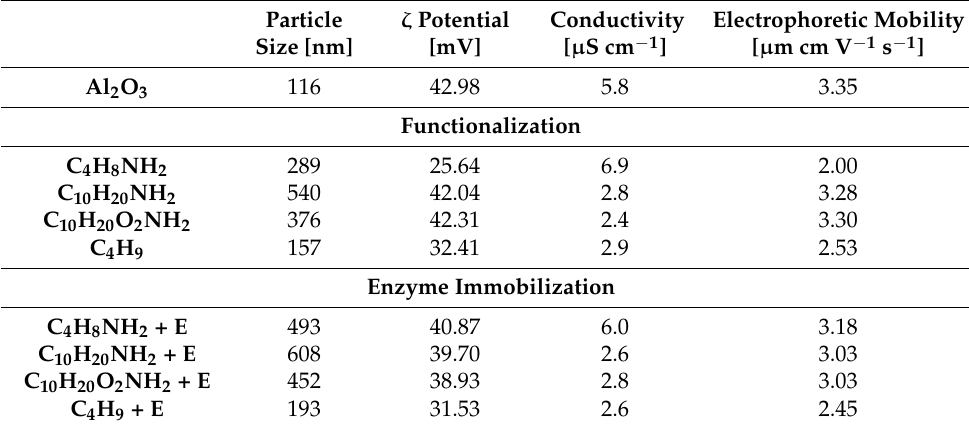
Table 1. Dynamic light scattering (DLS) and ζ —zeta potential characteristics of the ceramic